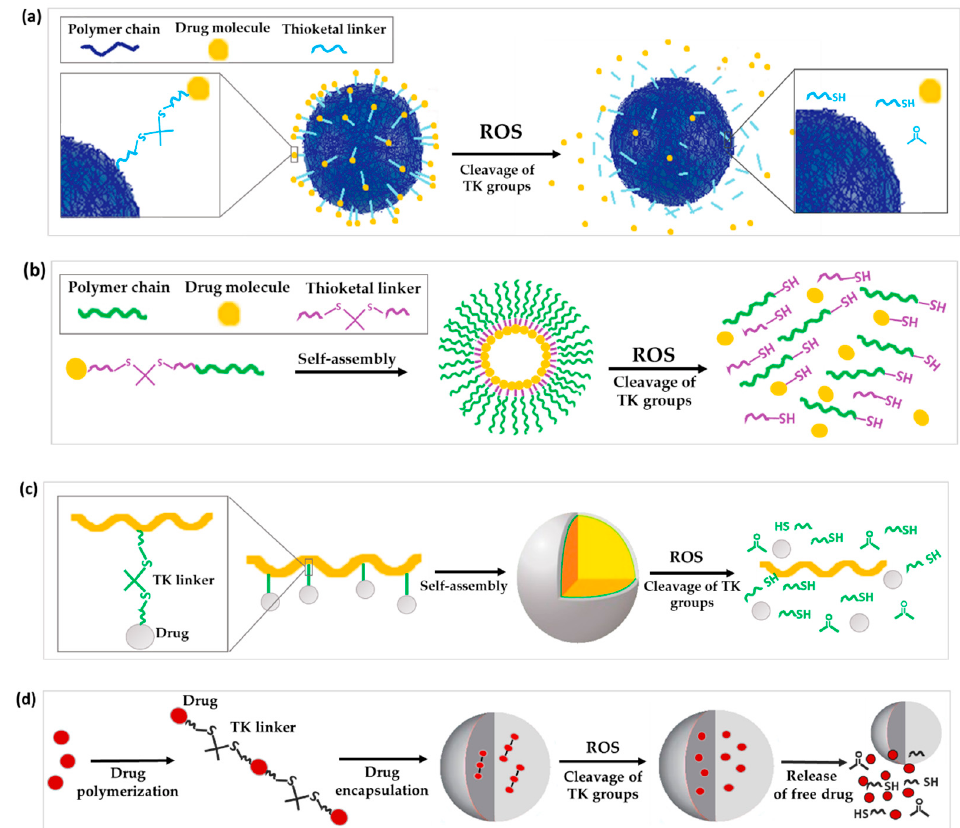
Figure 2. Schematic illustration of the chemical structure and corresponding release mechanisms of TK-based ROS-responsive nanosystems, where TK is used as ( a ) linker to attach drugs to the surface of nanoparticles, ( b ) linkage to form prodrug-based NPs, ( c ) linker to form polyprodrug-based NPs with drug molecules attached to the same polymer unit by TK linkages or ( d ) linker to form encapsulated polyprodrugs based on multiple drug molecules attached to each other via TK bridges.